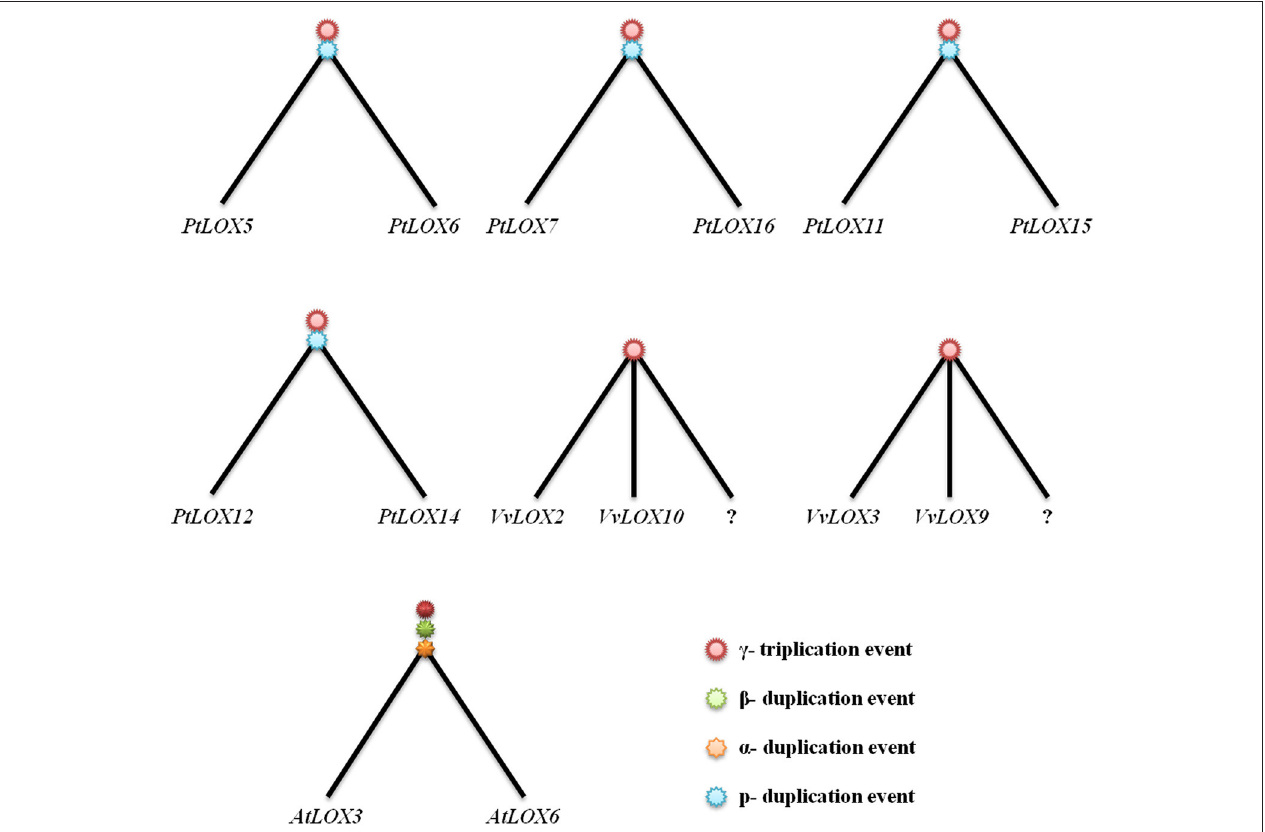
FIGURE 6 | Idealized gene trees of the duplication groups of LOX genes in Populus, Vitis , and Arabidopsis . Each tree represents a duplication group from large-scale gene duplication. As shown in the trees, the question marks indicate possible gene loss events. As shown in the trees, three paleopolyploidies affecting Arabidopsis ( α , β , and γ duplication event). Populus trichocarpa has two duplication events (p and γ duplication event) and γ , which is shared by Vitis . The question marks indicate possible gene loss